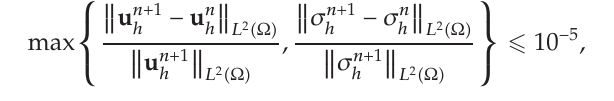
(cid:6) 2 / 2 (cid:2) b (cid:3) in time with time step k (cid:9) 0 . h 0